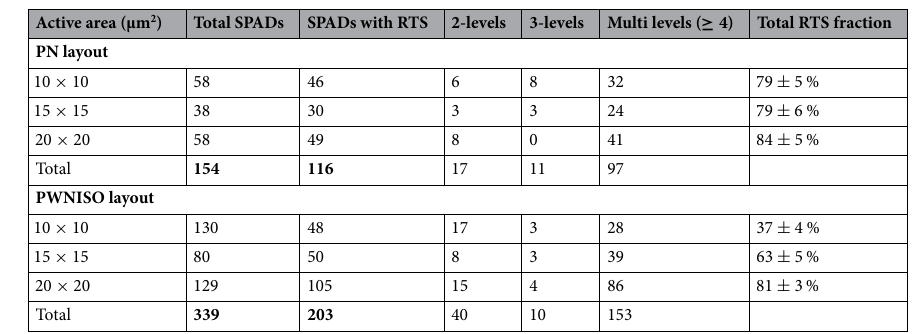
Table 3. RTS occurrence in irradiated SPADs with DDD=376 TeV/g.